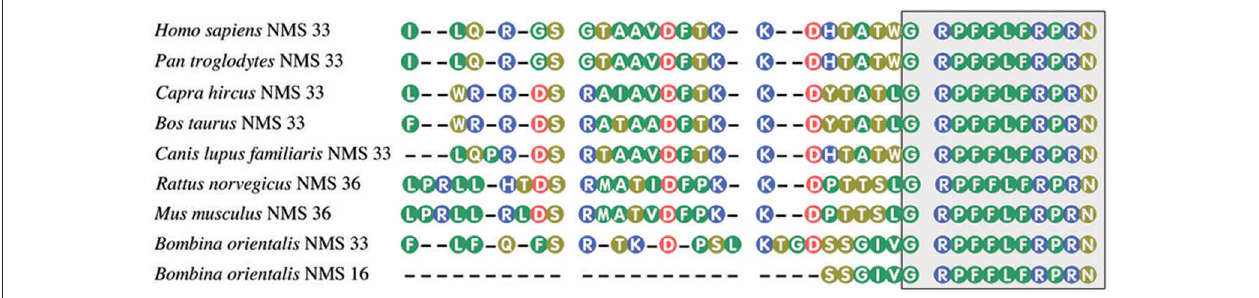
FIGURE 2 | Amino acid sequences of neuromedin S from some mammalian and amphibian species. The box, highlighting the C-terminal decapeptide, shows conservation of this sequence in vertebrates. NMU and NMS share the same amidated C-terminal heptapeptide. Amino acid sequences were acquired from NCBI. Numbers after NMS denote peptide